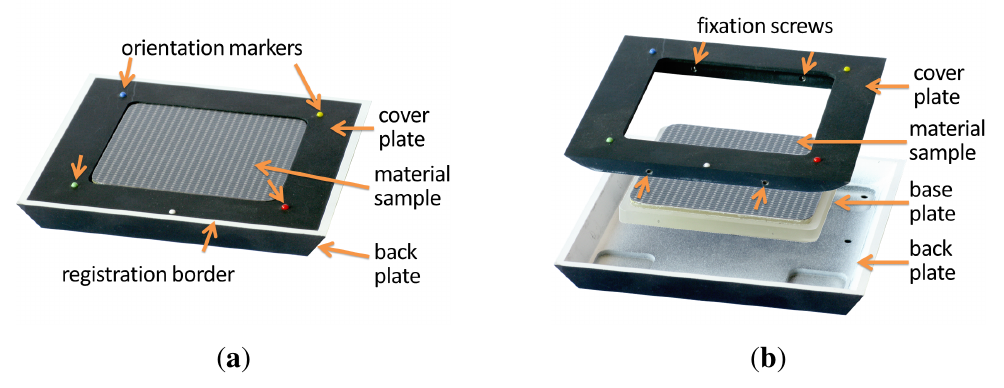
Figure 7. The sampleholder employed in the gonioreflectometer setup. ( a ) sampleholder with sample; ( b ) individual